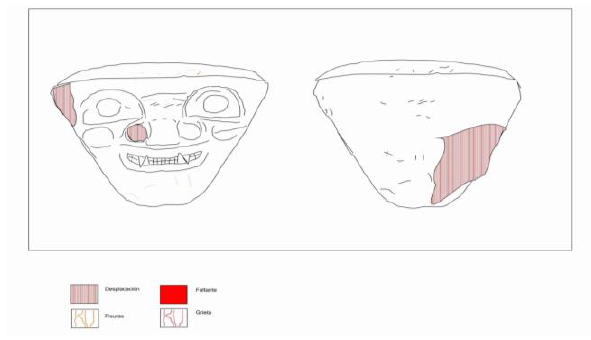
Figure 11. Alteration map of “Escultura 23”. (Preuss, 1974, table